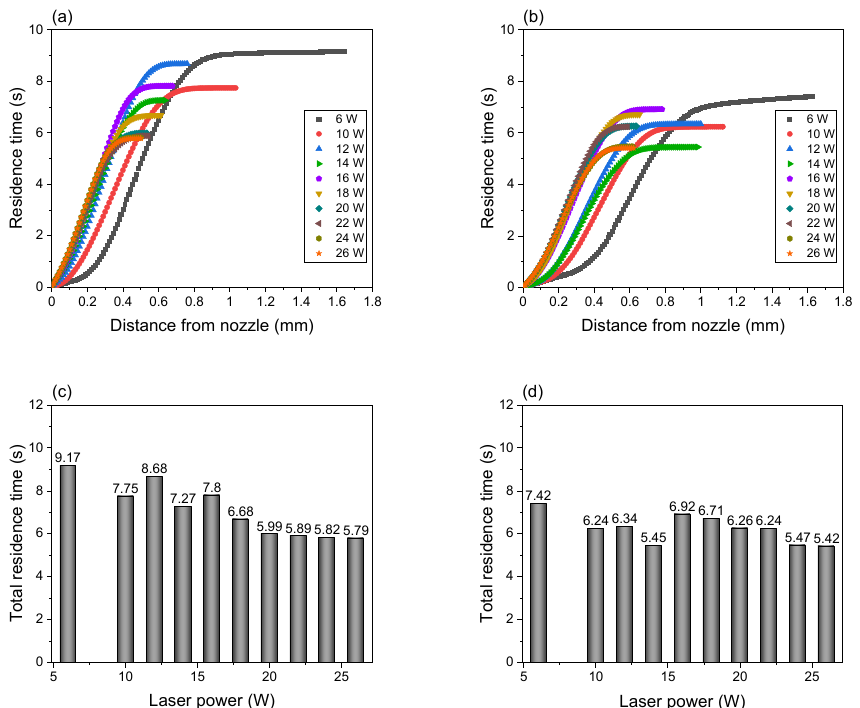
Figure 4. Residence time of ( a ) PLLA and ( b ) BC/PLLA fibers and total residence time of ( c ) PLLA and ( d ) BC/PLLA fibers near the nozzle at laser powers of 6–26 W.